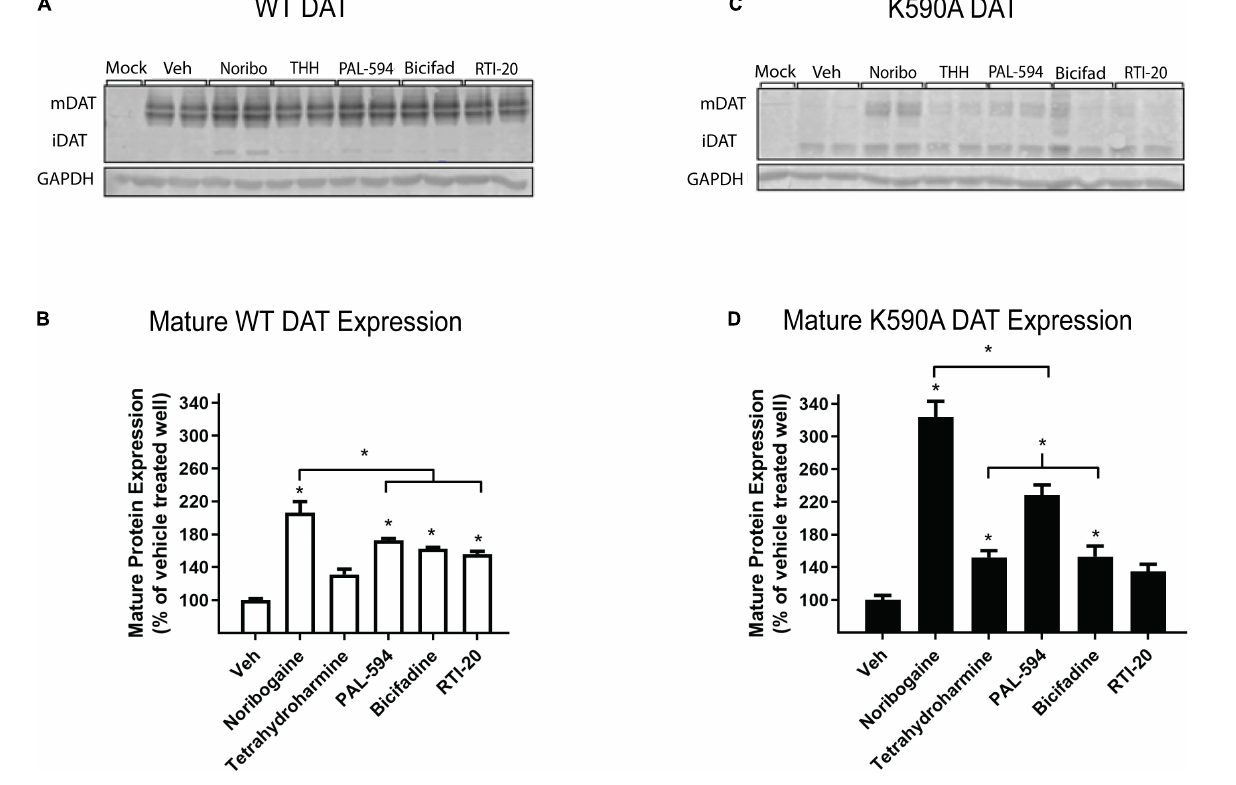
FIGURE 5 | Effect of noribogaine, tetrahydroharmine, PAL-594, bicifadine, and RTI-20 on WT and K590A DAT expression. (A) Representative blot of WT DAT cells treated overnight with 100 µ M noribogaine, tetrahydroharmine, PAL-594, Bicifadine, and RTI-20. Mature, fully glycosylated DAT (mDAT = 110 kDa) and immature, ER-resident DAT (iDAT = 75 kDa) are shown. (B) Quantification of WT mDAT protein levels. Data are means ± S.E.M; * = P < 0.05; n = 3–4. (C) Representative blot of K590A DAT cells. Mature, fully glycosylated DAT (mDAT = 110 kDa) and immature, ER-resident DAT (iDAT = 75 kDa) are shown. (D) Quantification of K590A mDAT protein levels. Data are means ± S.E.M; * = P < 0.05; n =